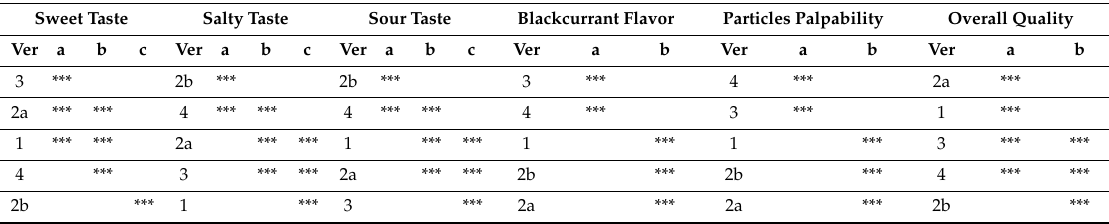
Table 5. Statistical analysis of the results obtained during the sensory evaluation of the designed recovery drinks; a–c—values marked by di ff erent letters di ff er significantly ( p < 0.05), *** determinant of belonging of a given drink to a specific homogeneous